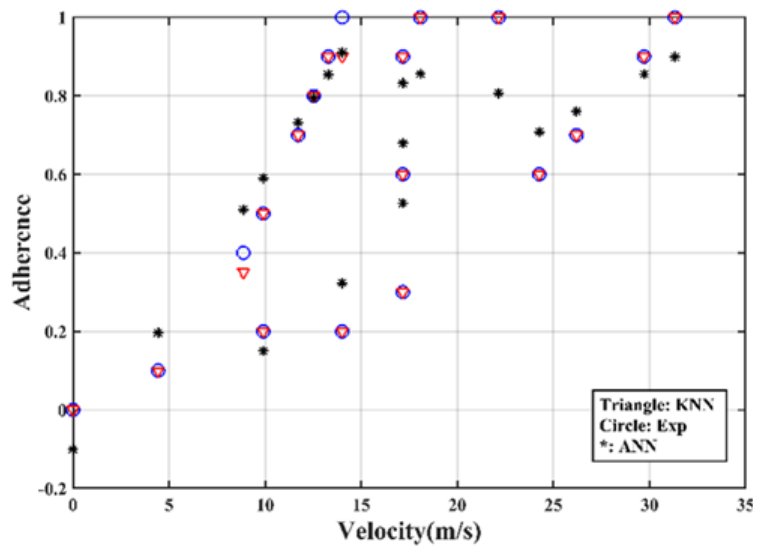
Figure 6. Adhesion values as a function of speed.